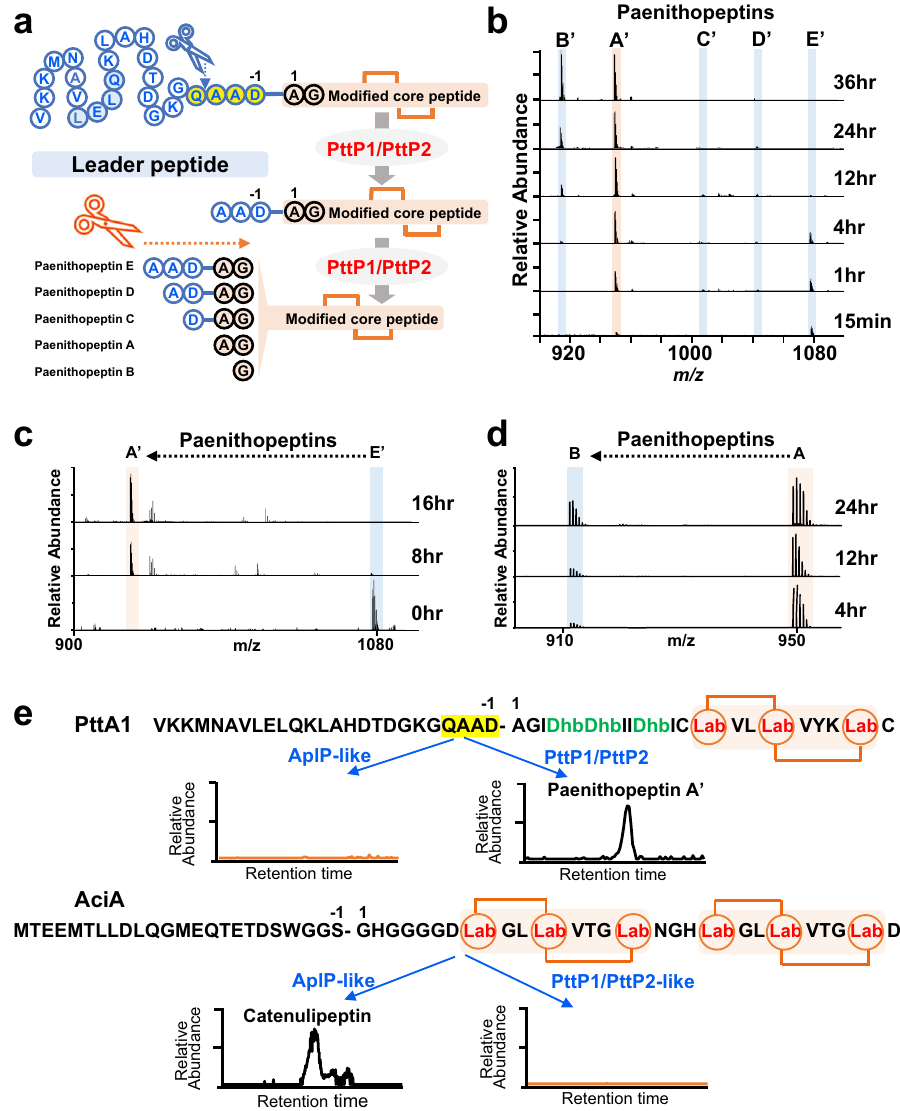
Fig. 6 PttP1/PttP2 showed substrate speci fi city and bifunctional proteolytic activity for leader peptide processing. a Representation of the